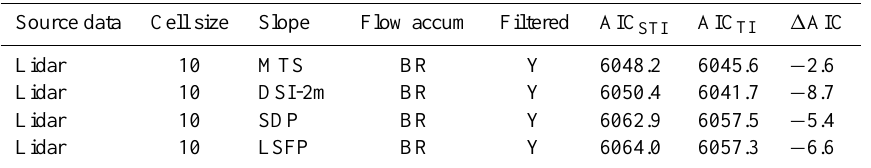
Table 4. Summary of the cases where the TI performed better than the STI in the lidar data set. In the filtered column, “Y” stands for yes and “N” stands for no.